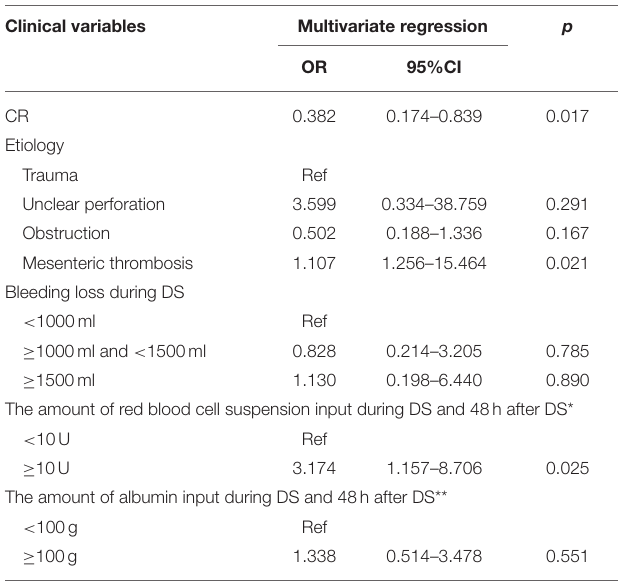
TABLE 9 | Multivariate logistic regression analysis of the risk factors for recurrent fistula after PSM. Clinical